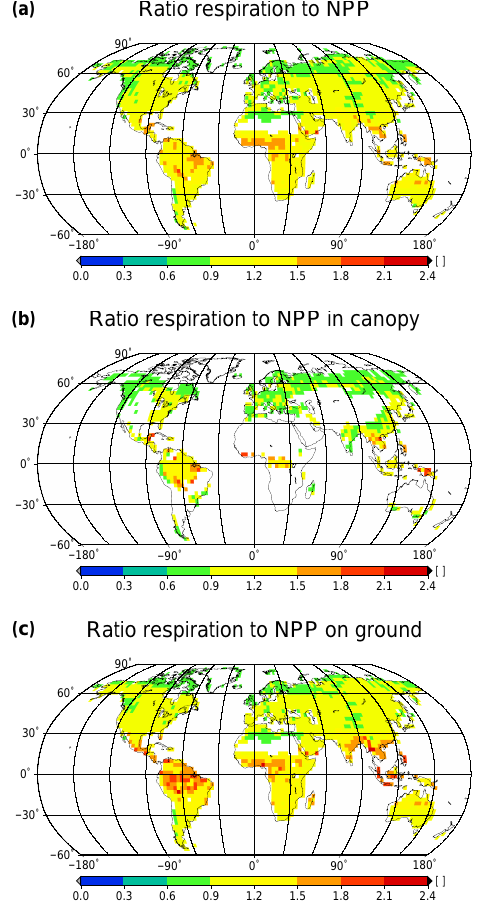
Figure 4. Global patterns of the ratio of respiration to NPP. Ratio of respiration to NPP of lichens and bryophytes estimated by LiBry for (a) all locations of growth, (b) the canopy and (c) the ground.